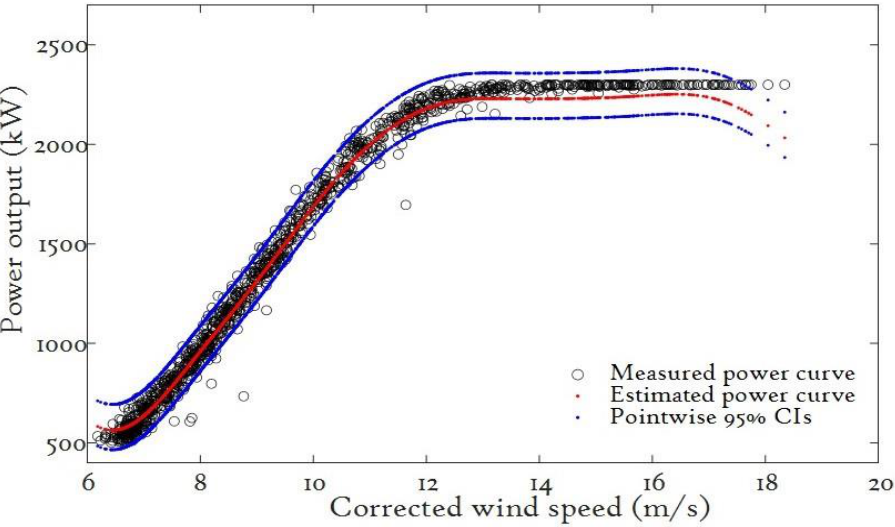
Figure 7. Pointwise CIs for SVM-based power curve.